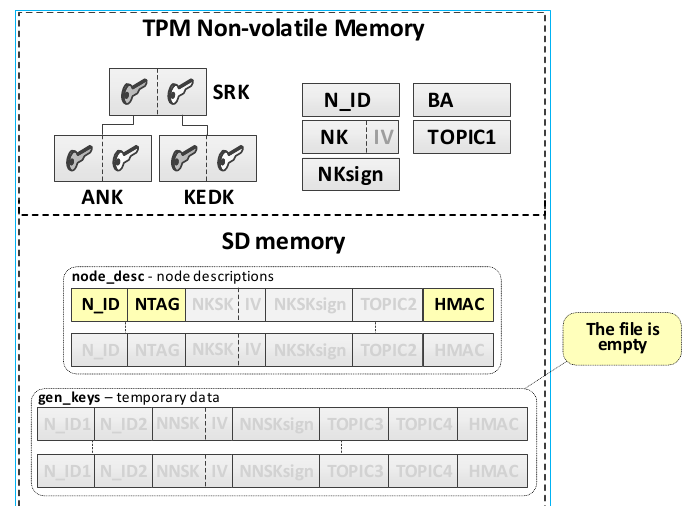
Figure 9. An example of data stored on the KS node after adding the description of the first N node.